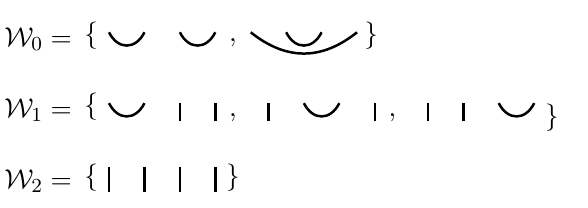
Figure 20 . The representation spaces of the Temperley-Lieb algebra acting on N = 4 strands.